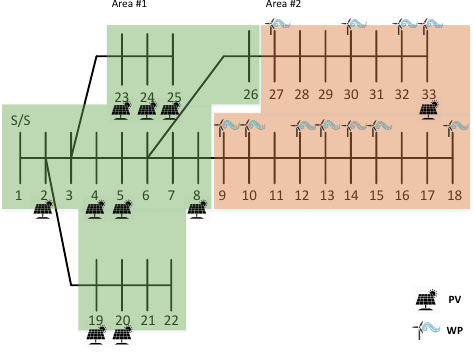
Figure 25. Snapshot Approach—50% Value—Scenario #1